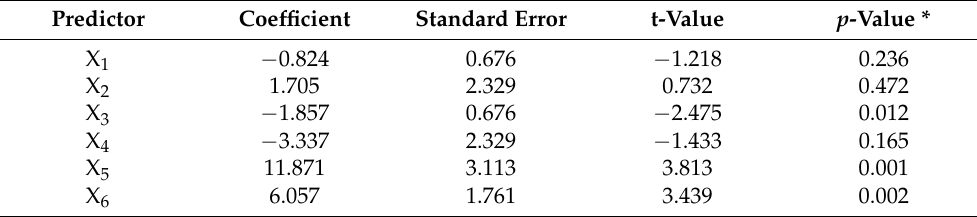
Table 3. Regression model results of MgSO 4 rejection